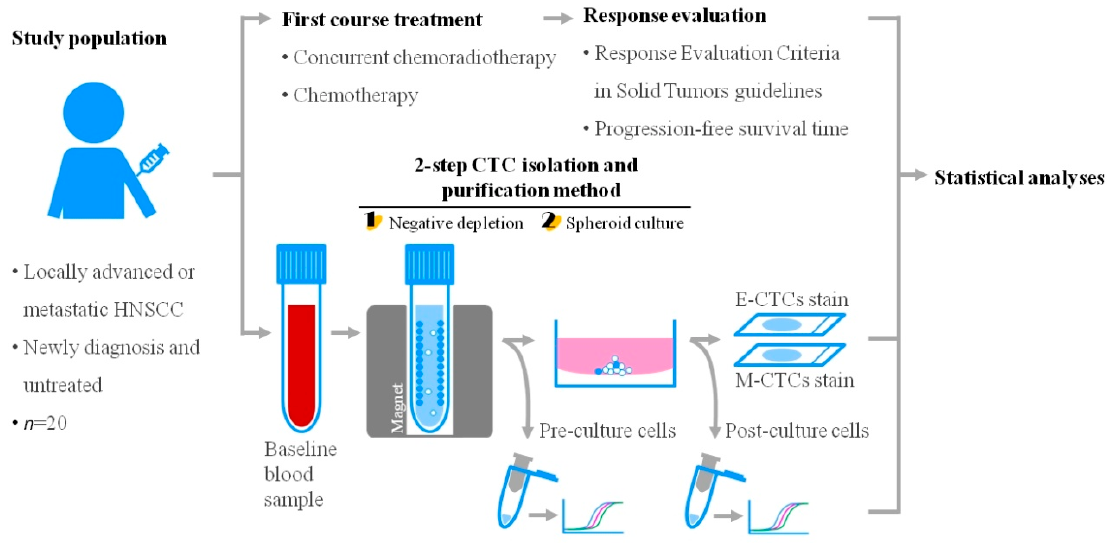
Figure 1. The overall flow chart of this study (HNSCC: head and neck squamous cell carcinoma; E-CTCs: epithelial type-CTCs; M-CTCs: mesenchymal-type CTCs).